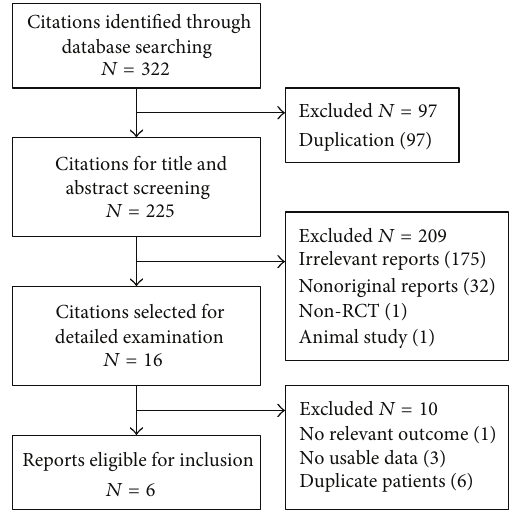
Figure 1: Flow diagram of study identification and